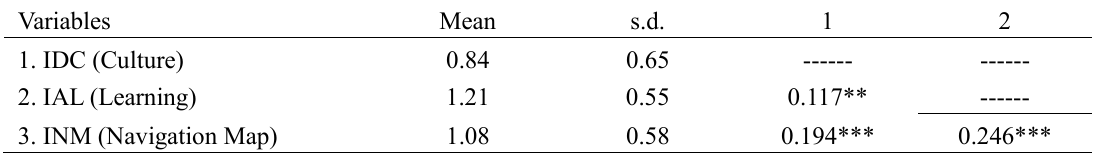
Table 2. Pearson Product Moment Correlations and Descriptive